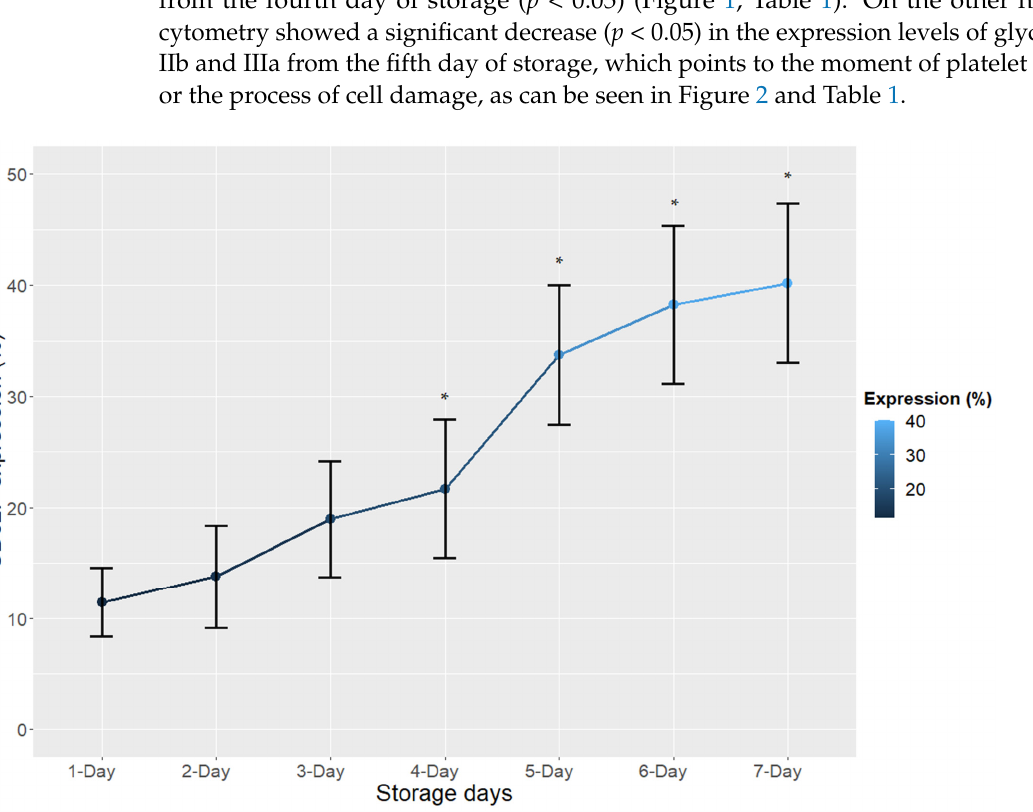
Figure 1. Expression (%) of the CD62P receptor in platelet concentrates during the 7 days of storage. The error bars represent the variability of the data that were calculated from the standard deviation; * p < 0.05.